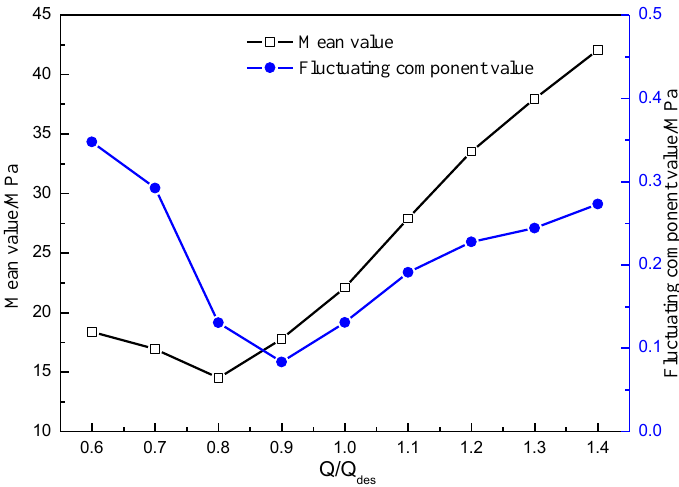
Figure 20. Comparisons of the equivalent stress in the center of the shaft under different flow conditions.